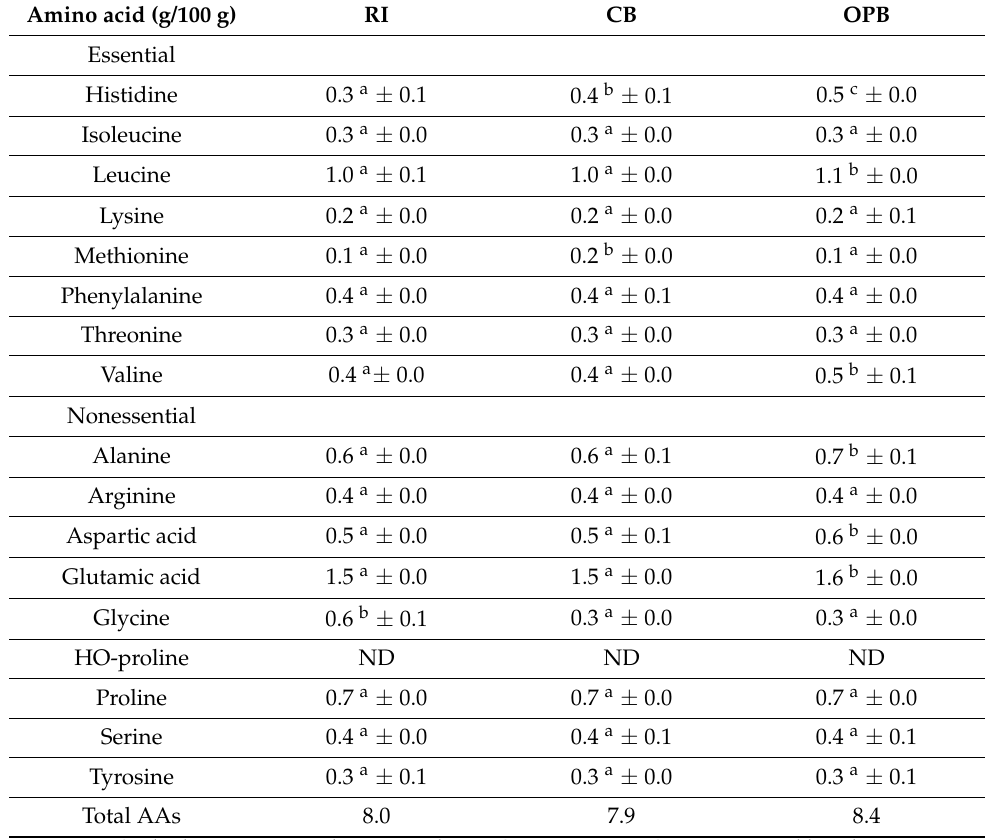
Table 3. Amino acid profile of umqombothi .